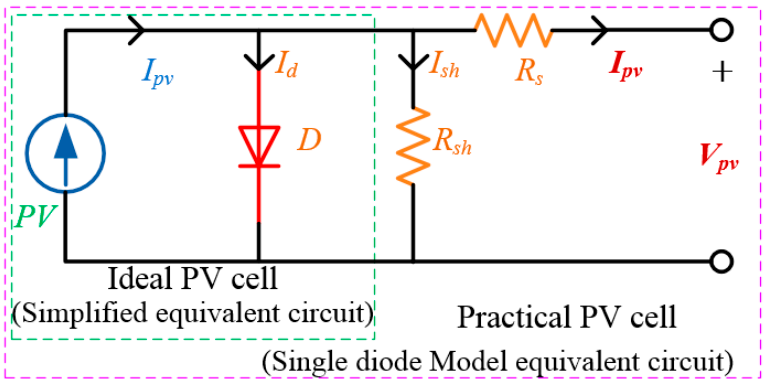
Figure 1. Single diode model and equivalent circuit of the photovoltaic (PV) cell.